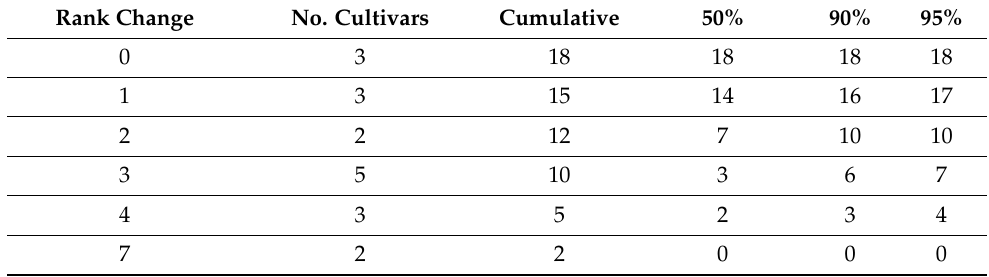
Table 5. Absolute yield rank differences for combined 2011–2014 trials. Number of cultivars shows the number of cultivars with the given rank change and Cumulative shows the number with that rank change or greater. The 50%, 90% and 95% points are from the simulated variables and show the distribution of the number of cultivars that exhibited an absolute rank change at least as large as that specified due to random variation, as described in the